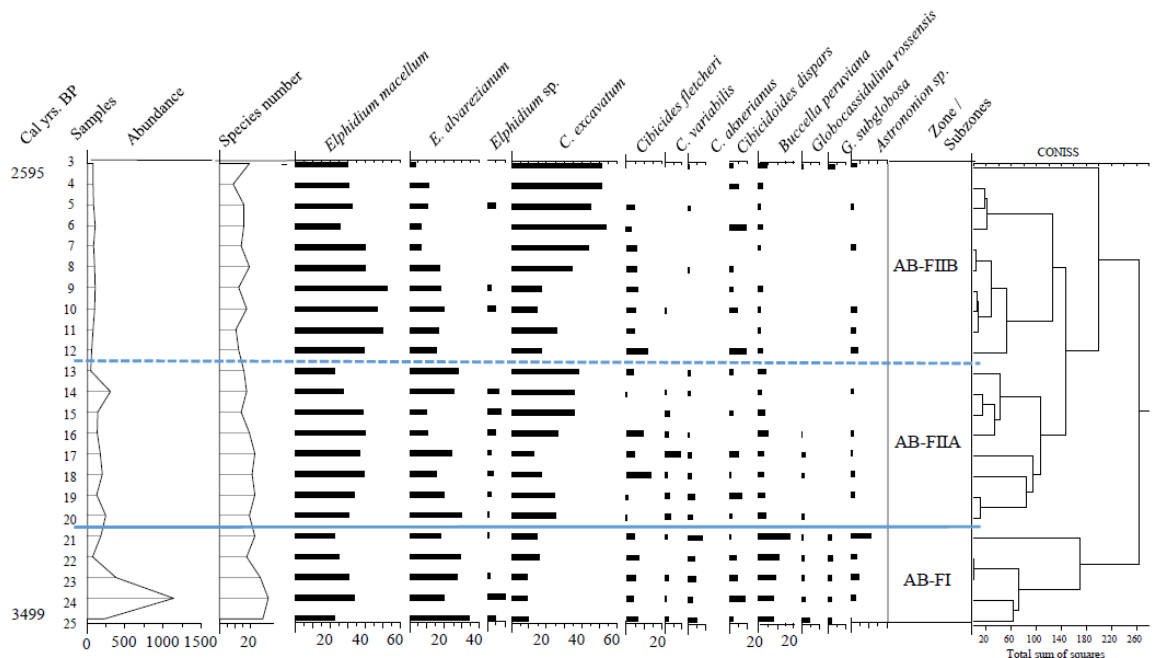
Figure 3. Distribution of foraminiferal species in Arroyo Baliza with ≥2 % of relative abundance at least in 2